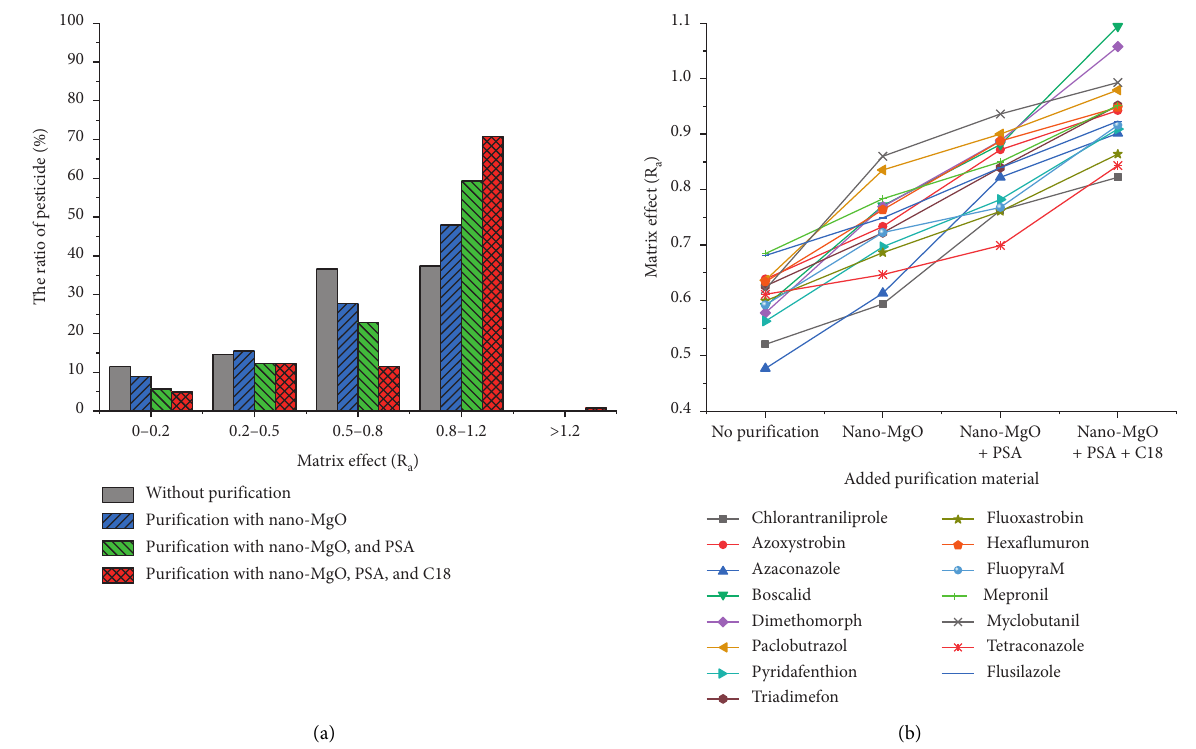
Figure 3: Effects of different purifications on matrix effect of pesticides (a) and fifteen representative pesticides